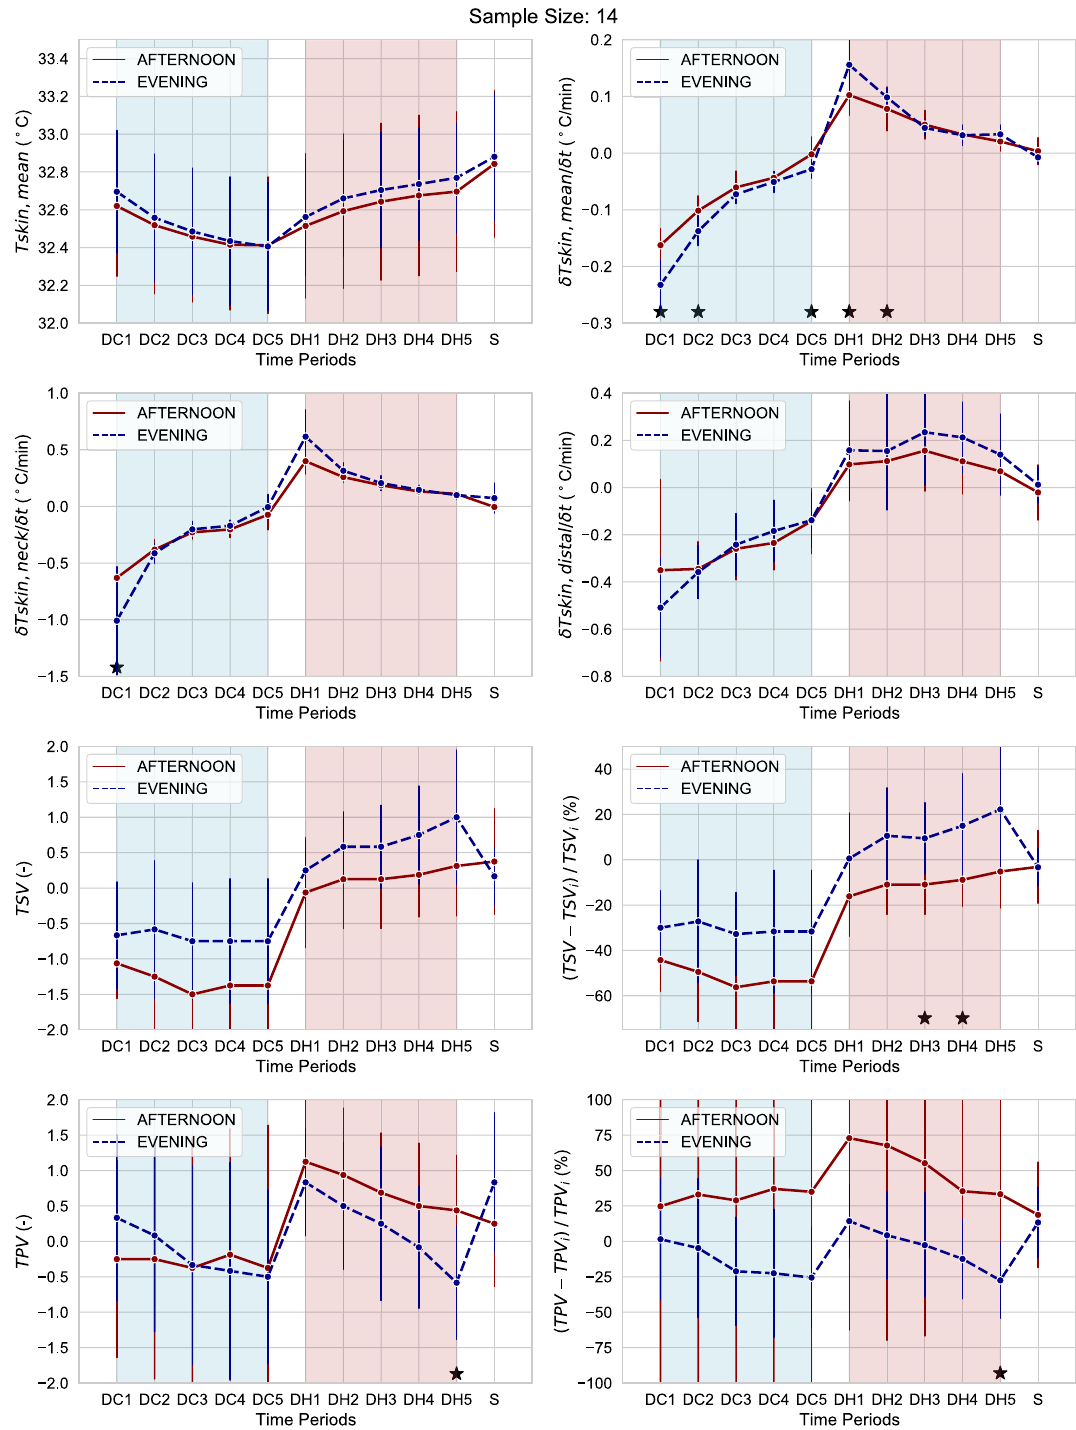
Figure 6. Skin temperature at various locations, subjective thermal sensation and thermal pleasure vote and their rate of change in the afternoon and evening averaged over the course of the last two partial-body cooling and warming transients. Thus, only data collected after 120 min from the beginning of the test are reported. Asterisks indicate statistically significant differences. Error bars represent one standard